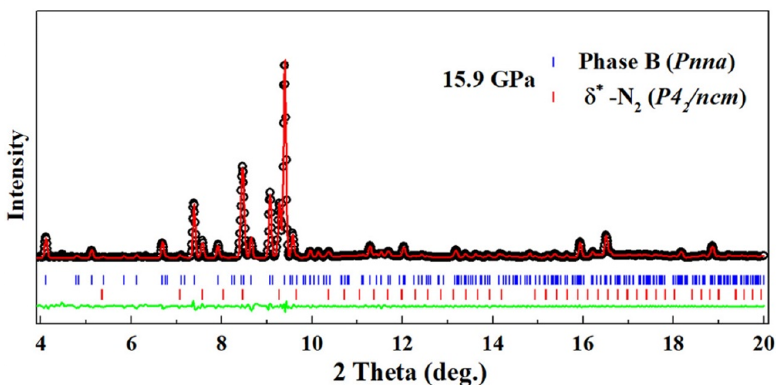
Figure 5. XRD pattern of the pure AA sample at 15.9 GPa–300 K after the high P - T transformation. The background has been subtracted for easier visualization. Experimental data are shown by red circles. The black line is a two-phase Le Bail fit of the pattern using the Pnna unit cell for phase A and δ ∗ -N 2 ( P 4 2 / ncm ). The blue line is the fit residual. Ticks indicate the position of the Bragg peaks of each